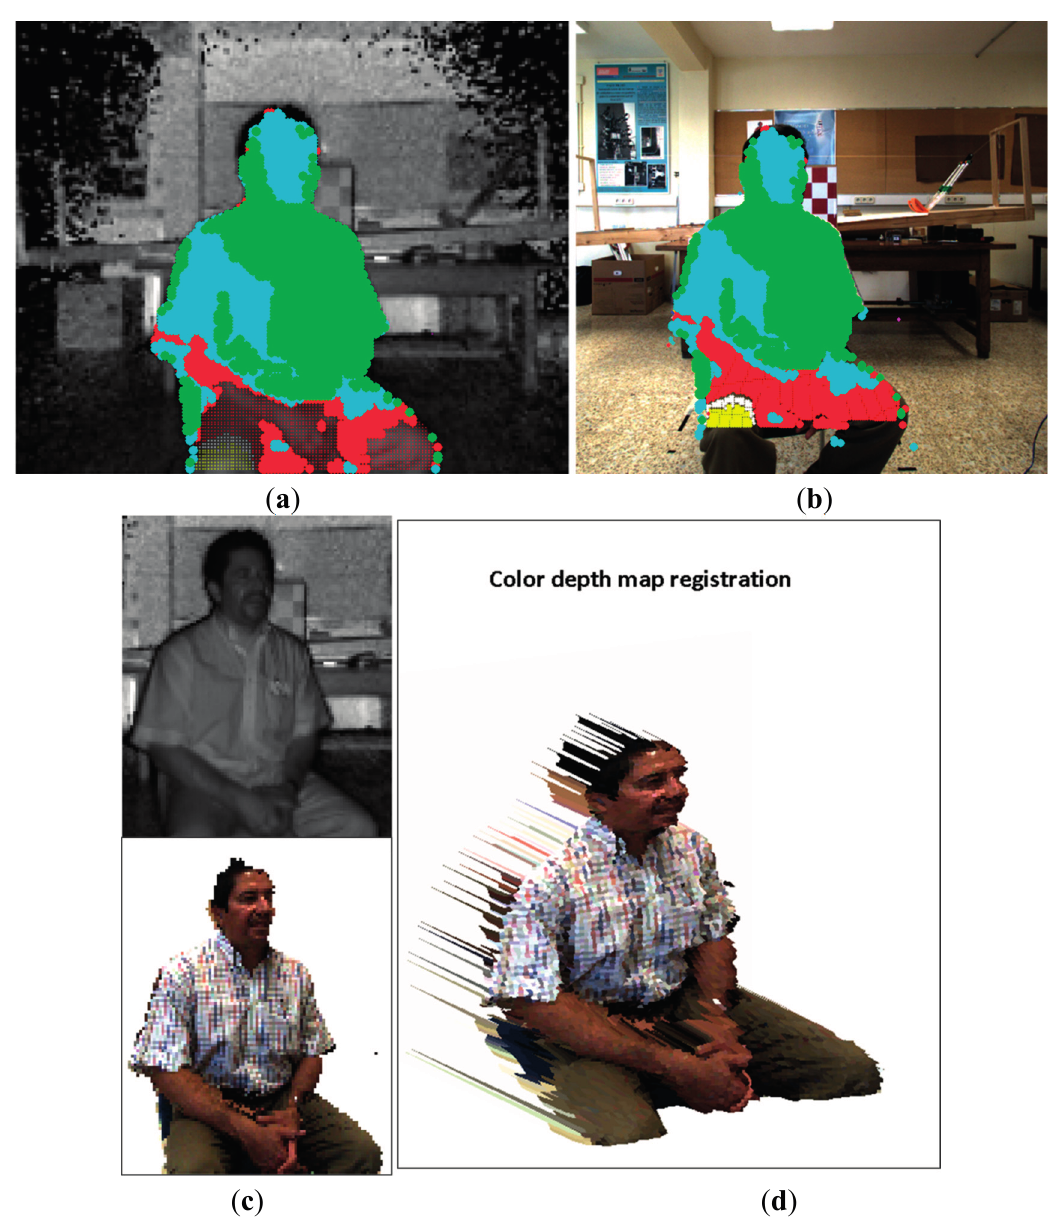
Figure 14. Image sample 33. ( a ) Selected points on the ToF; ( b ) estimated points on the RGB image; ( c ) Top: selected ToF ROI. Bottom: estimated RGB ROI; ( d ) the colour depth map of the